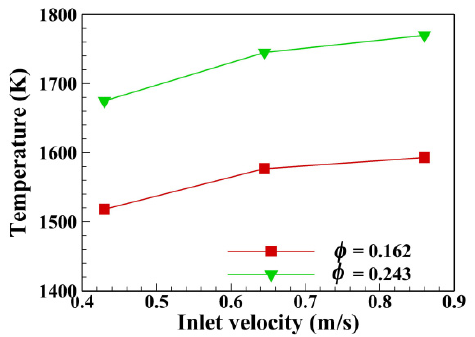
Figure 8. E ff ect of gas mixture inlet velocity on the peak flame temperature. Figure 8. Effect of gas mixture inlet velocity on the peak flame temperature.